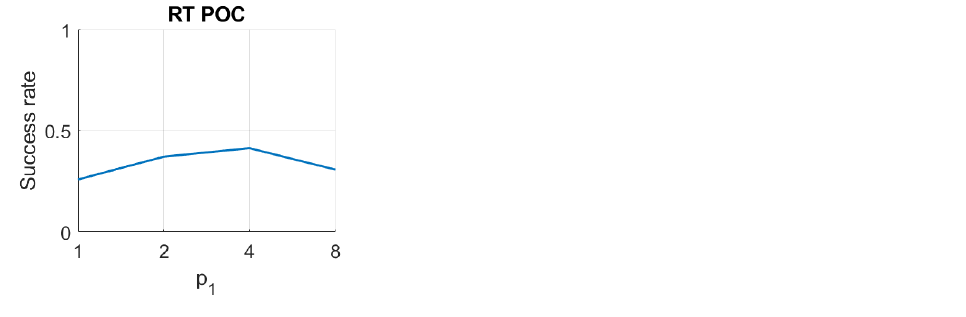
Figure 12. RT–POC image retrieval problem. Success rate of the method. p 1 is the relative angle (deg) between the lines en each set (Table